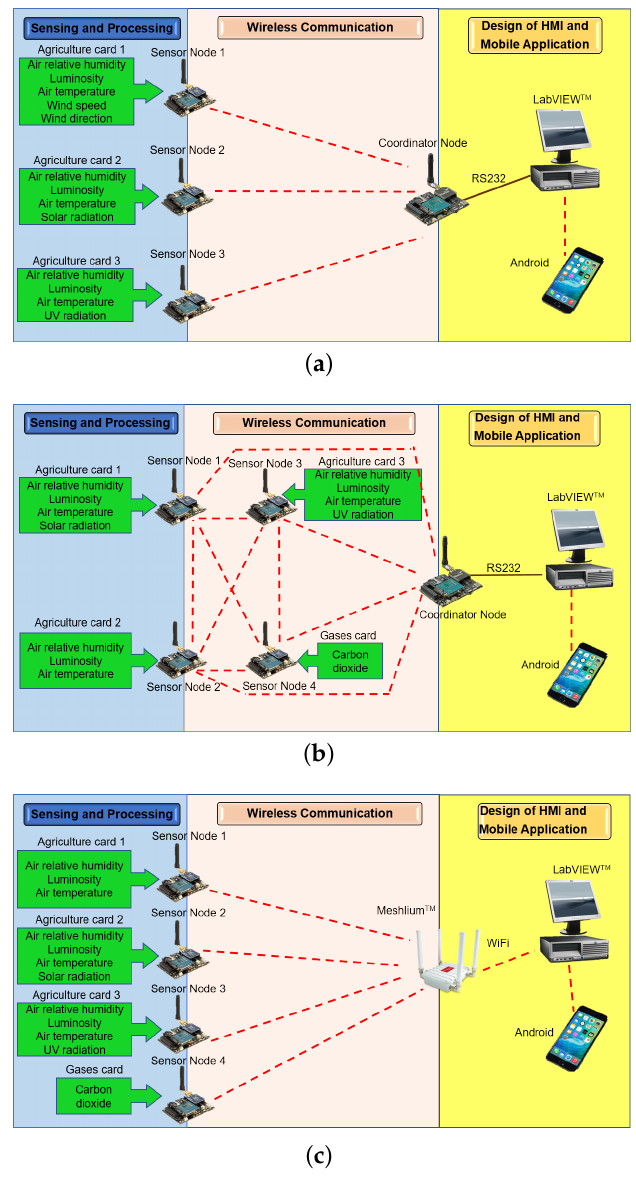
Figure 1. Schemes of the sensors and network topology of the studied WSNs: ( a ) ZigBee; ( b ) DigiMesh; and ( c )